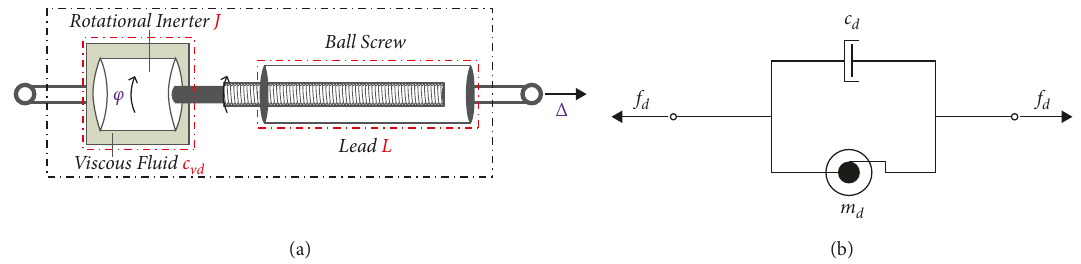
Figure 2: Structure and mechanical model of an inerter viscous damper (IVD): (a) IVD; (b) mechanical model.